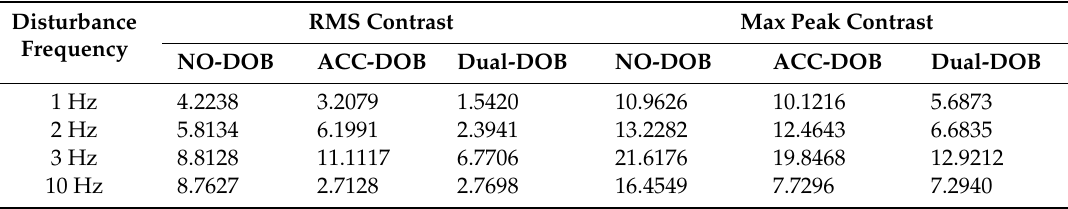
Table 1. Time-domain error, mean square, and peak comparison of three structures with disturbance frequencies of 1, 2, 3, and 10